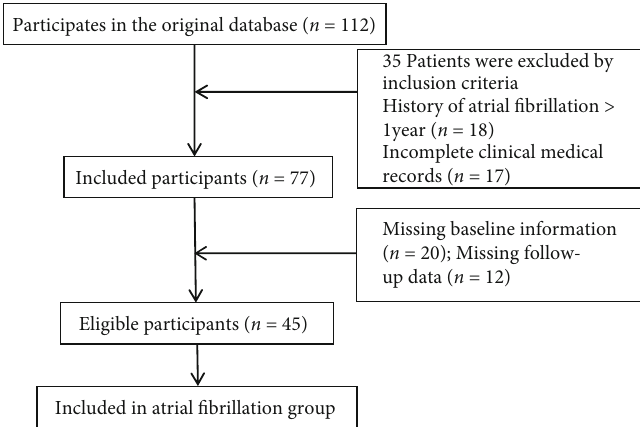
Figure 1: Flow chart of data